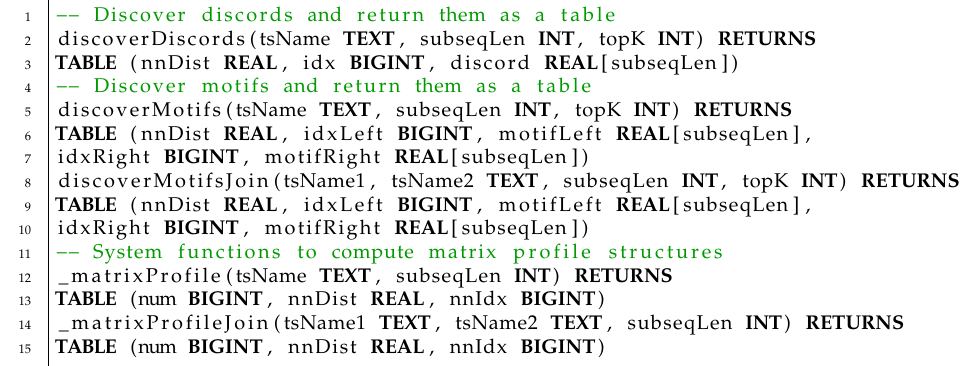
Figure 13. Time series data mining API, MPPostgres.